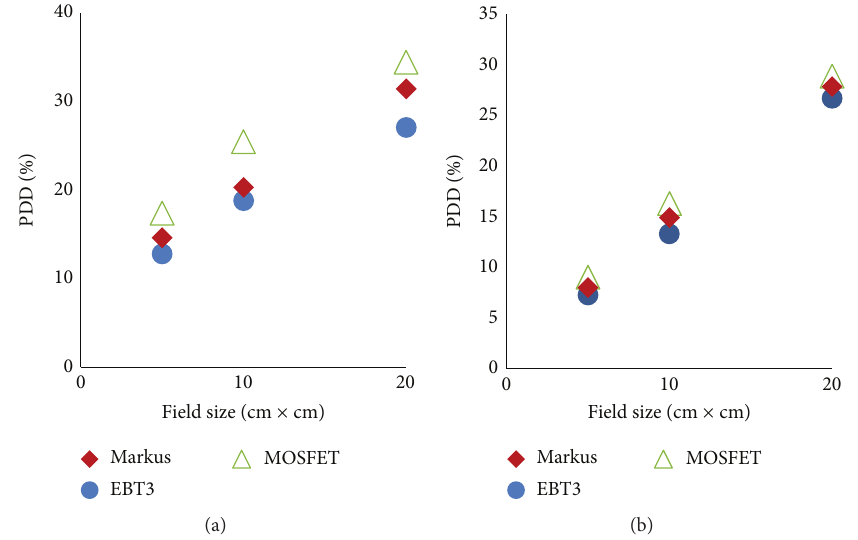
Figure 5: Percentage dose at the surface (0.07 mm) for 6MV (a) and 15MV (b) photon beams as a function of field size at 100cm fixed SSD for Markus parallel-plate ionization chamber, EBT3 film, and MOSFET